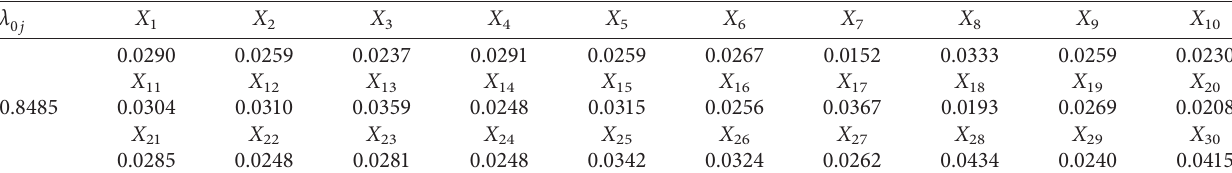
Table 5: Comprehensive gray relation degree shares of the core competence indicators of Chinese research universities. λ 0 j